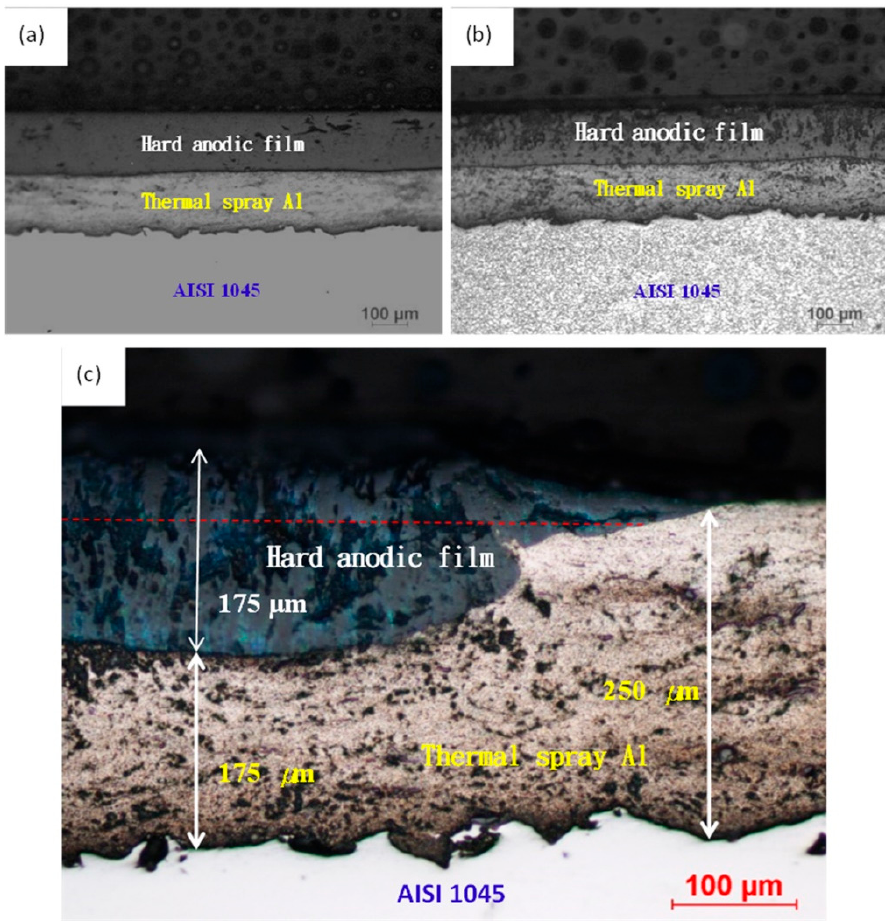
Figure 11. Following hard anodizing, optically micro-scans of thermally sprayed Al over AISI 1045 are shown in ( a ) prior etching, ( b ) post etching, and ( c ) a rather enlarged perspective. Reprinted with permission from [10]. Copyright 2021 MDPI. Distributed under Creative Commons Attribution-based license (CCBY 4.0.).